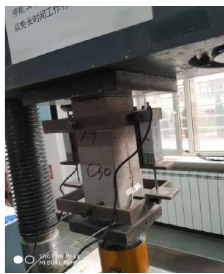
Figure 4. Test device and loading